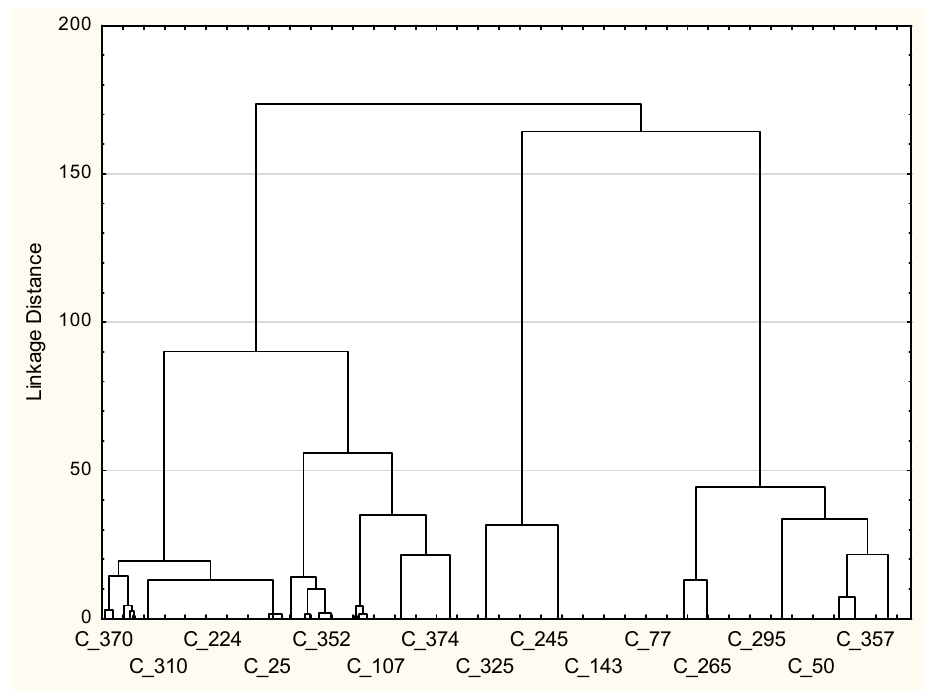
Figure 2. Three-cluster solution: Ward’s method with squared Euclidean distance measures.